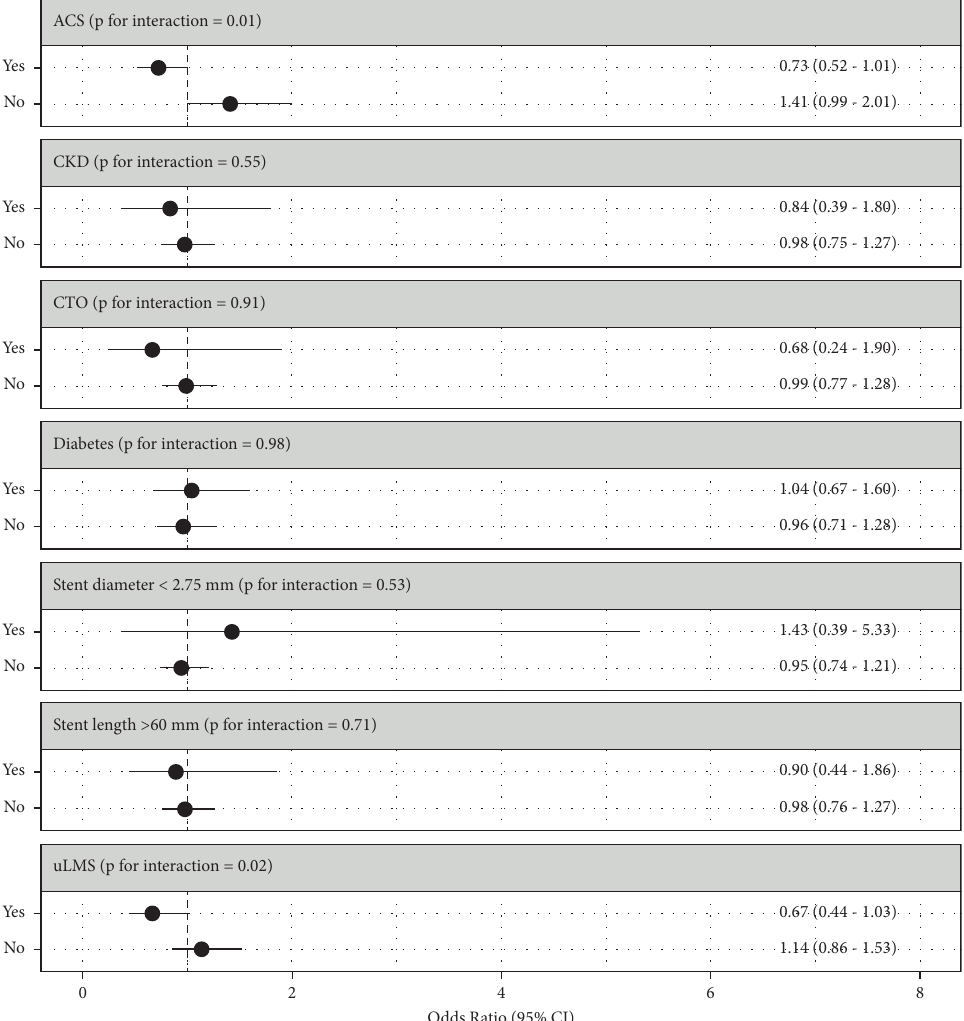
Figure 4: Subgroup analysis of adjusted 12-month mortality by intracoronary imaging use in RA-PCI in England and Wales, 2007 − 2014. CI: confidence interval; MACCE: major adverse cardiac and cerebrovascular